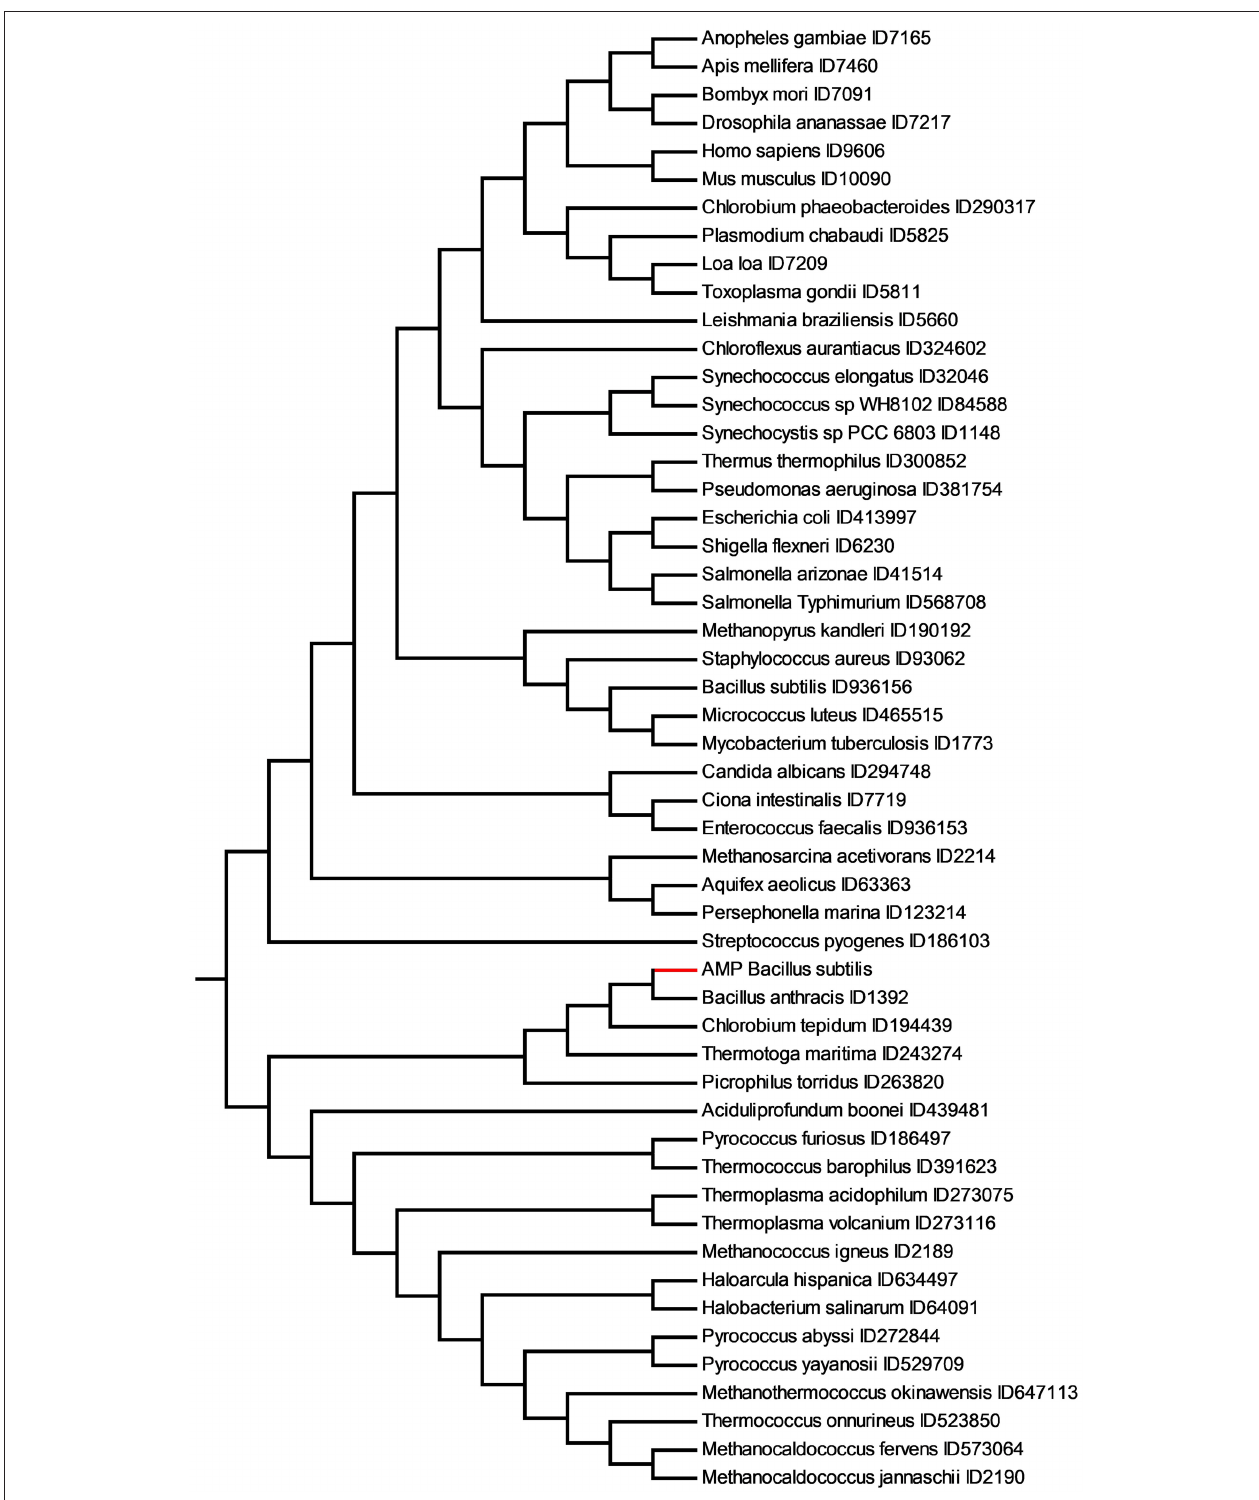
FIGURE 6 | Similarity relationships among the set of 147 AMP active against B. subtilis (AMP Bacillus subtilis) and the TMP dataset obtained with Equation (2) and substring length between 6 and 12. The AMP active on B. subtilis are shown in red.